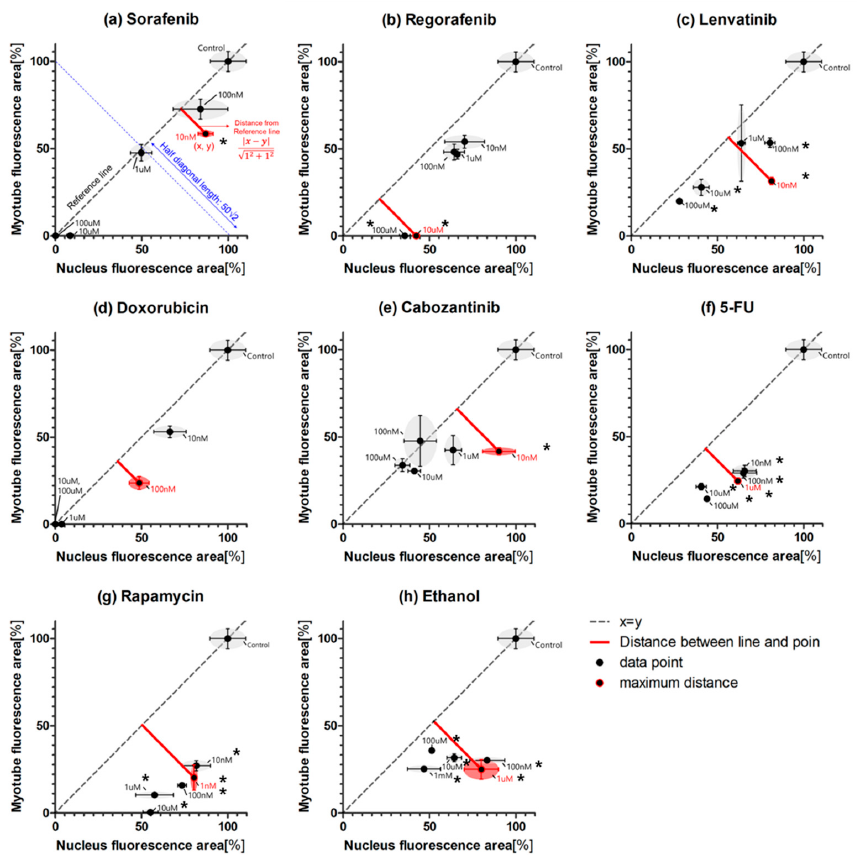
Figure 5. Distribution of myotube and nucleus fluorescence areas at different drug concentrations. The black dashed line (reference line) indicates the 50:50 ratio of myotubes and nuclei. The red solid line represents the maximum distance between the reference line and data points. “*“means the p -value between nucleus and myotube is less than 0.01. ( a ) Sorafenib. ( b ) Regorafenib. ( c ) Lenvatinib.